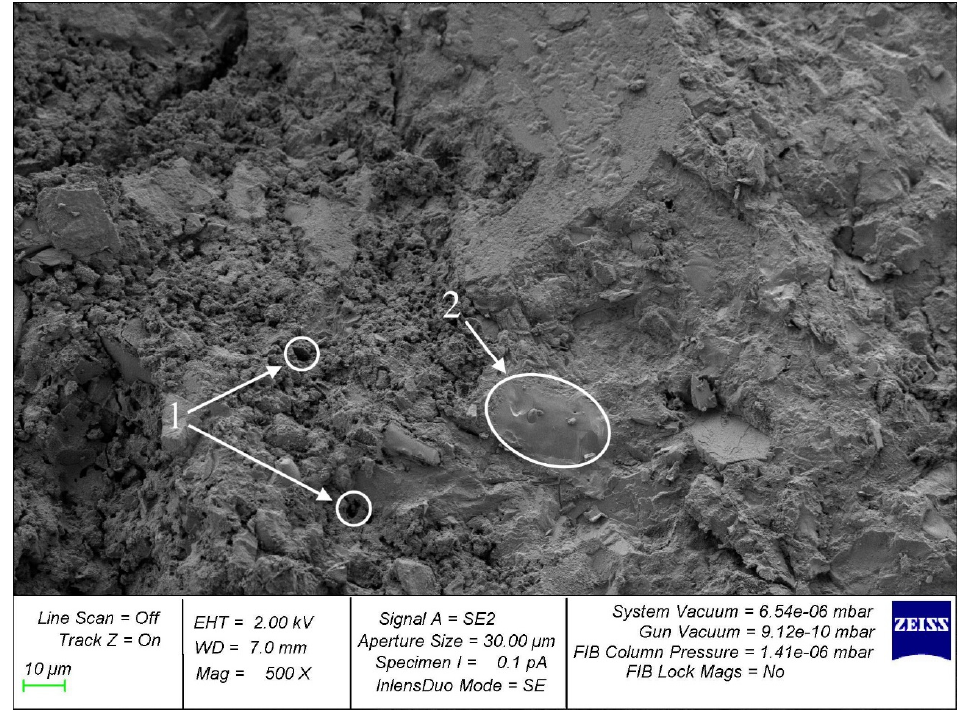
Figure 14. Sample with 6% snail shell powder dosage (1—porosity, 2—binder phase).